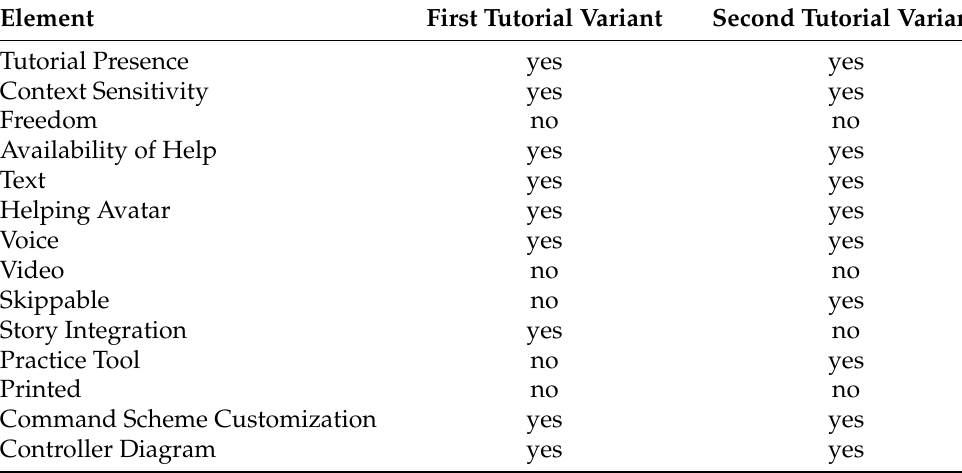
Table 2. Summary of the gaming features included in first and second tutorial